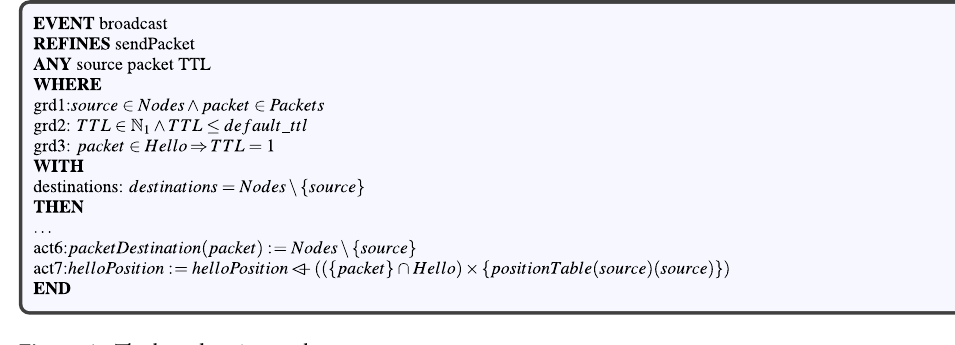
Figure 6. The broadcasting packet